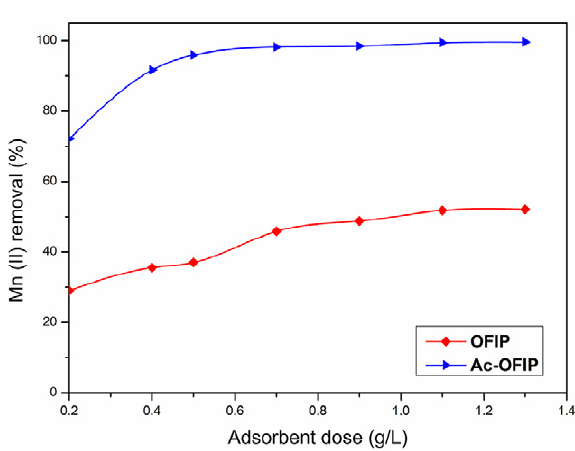
Fig. 4. Effect of adsorbent dose on the elimination of Mn (II) ions for OFIP and Ac-OFIP.